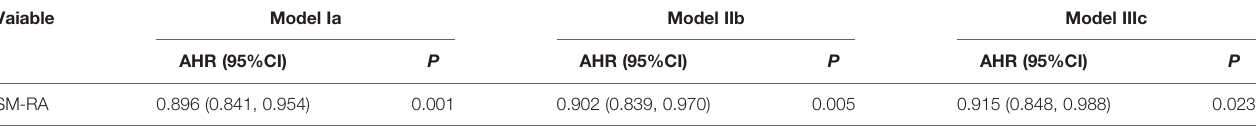
TABLE 3 | Associations of lower SM-RA with progression free survival (PFS) of HAIC combined with immunotherapy in 52 patients with advanced HCC. Vaiable